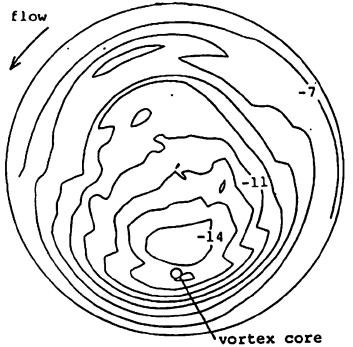
Figure 1. Pressure distribution in a cross section of a conical diffuser with a RVR. Reprinted with permission from [17], 1984, IAHR.